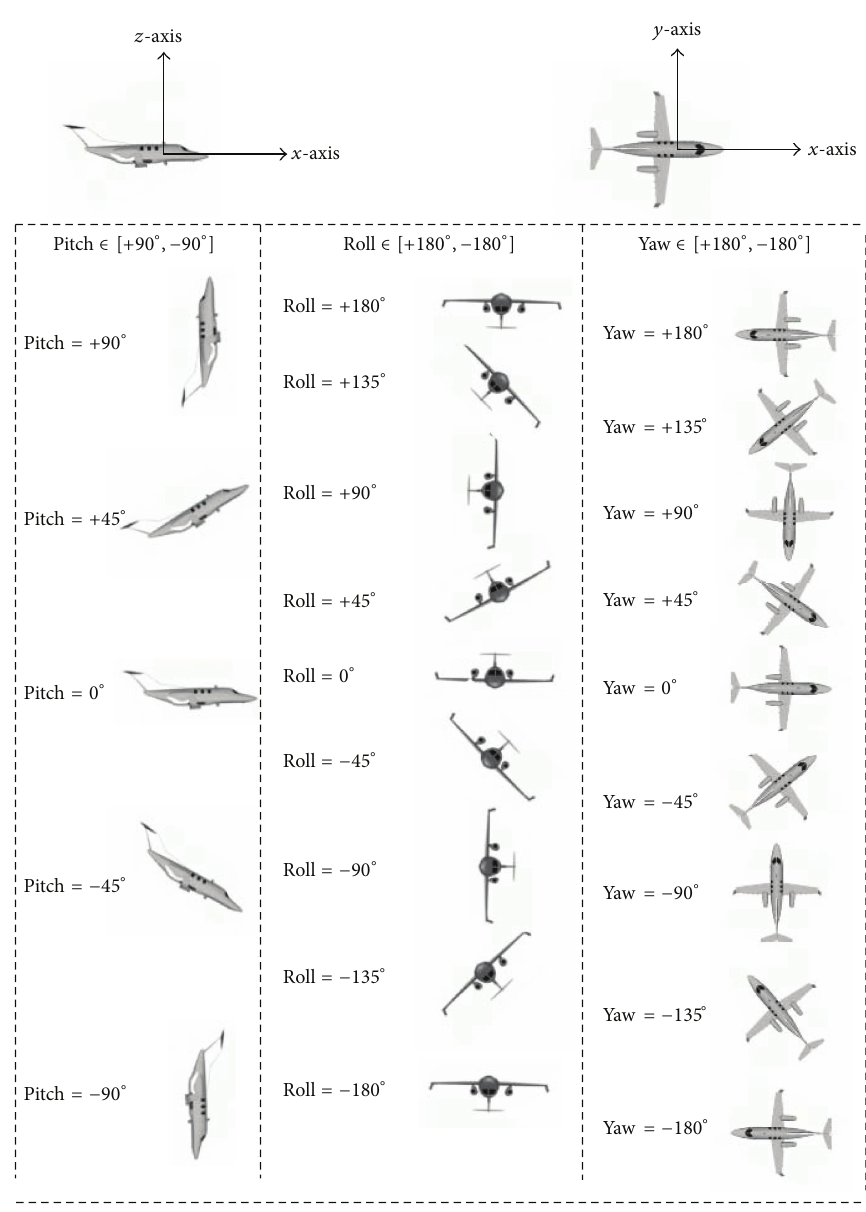
Figure 3: Aeronautical platform Euler angle